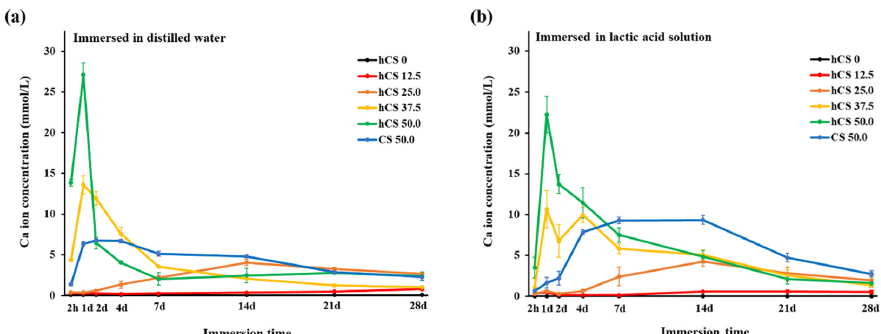
Figure 5. Concentration of Ca ion released into a refreshed solution at each measurement time point from 2 h to 28 d in distilled water ( a ) and lactic acid solution ( b ). Each value represents the average of 5 repeated measurement, and the error bars indicate the standard deviation of the average values (average ± standard deviation; n = 5).